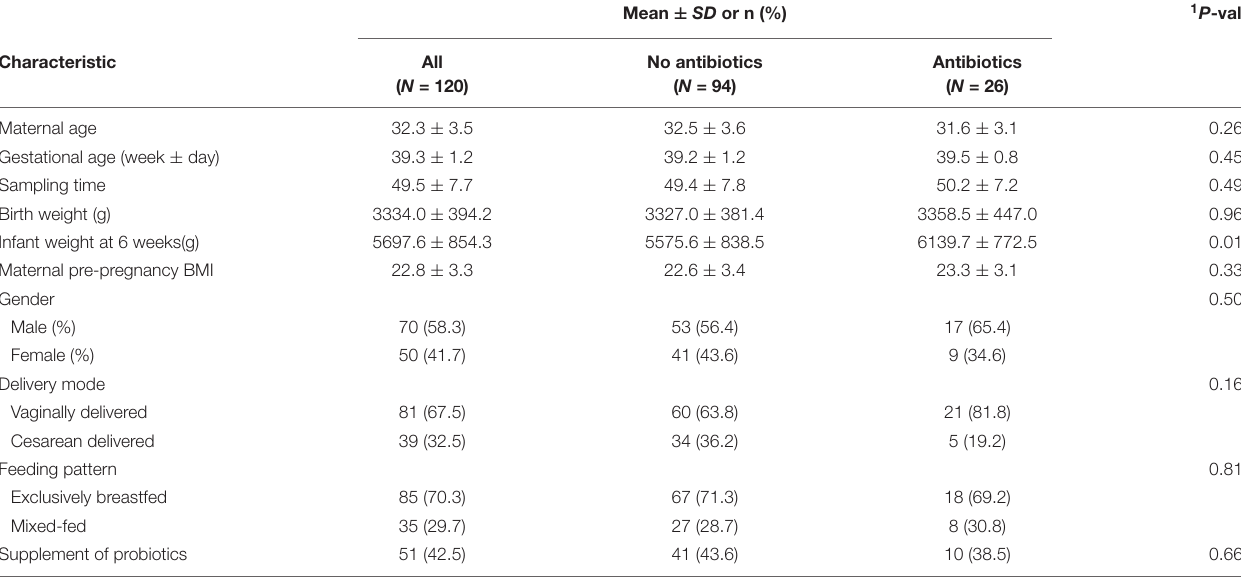
TABLE 1 | Characteristics of infants by postnatal antibiotic exposure ( n = 120).